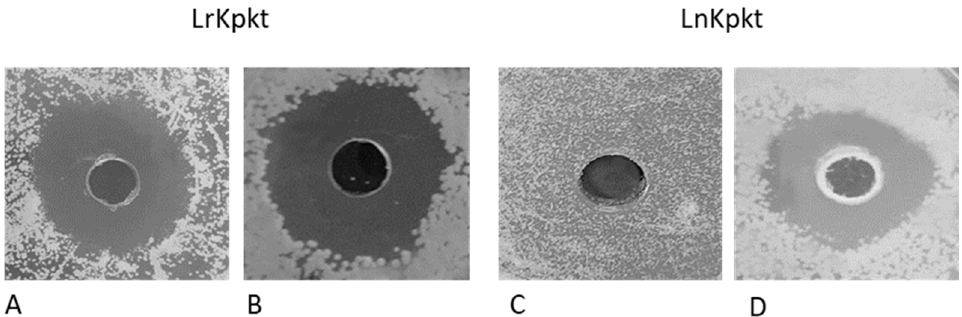
Figure 1. Well plate assay of lyophilized preparations of recombinant (LrKpkt) and native (LnKpkt) Kpkt. D. bruxellensis DiSVA 692 ( A , C ) and S. cerevisiae DBVPG 6500 ( B , D ) were utilized as sensitive strains.